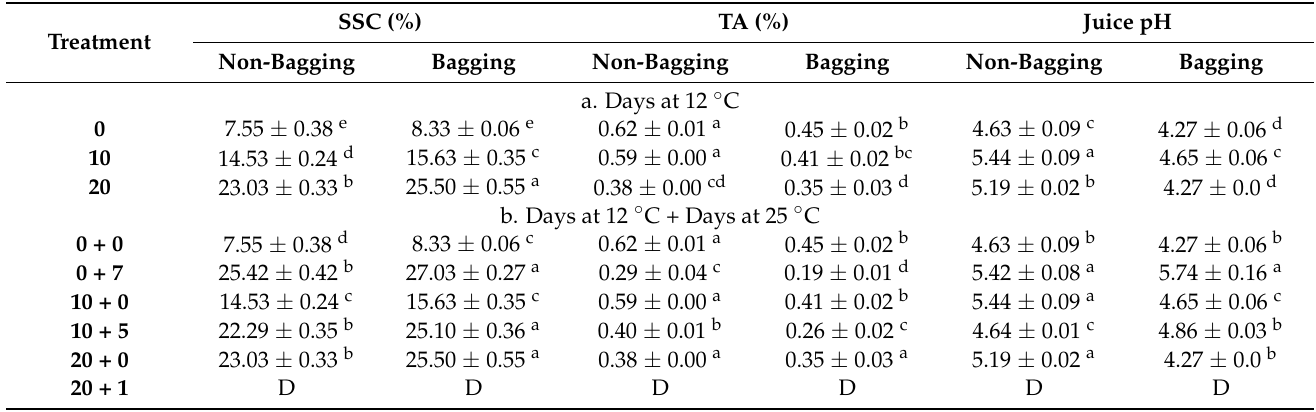
Table 2. Effect of on-tree fruit bagging treatments on soluble solids contents (SSC), titratable acidity (TA) and juice pH in mango fruit during cold storage intervals and under ambient conditions. Values are means of triplicates ± SD. Different letters in superscripts indicate significant differences according to LSD test at p ≤ 0.05. D, decayed fruit hence no tests were